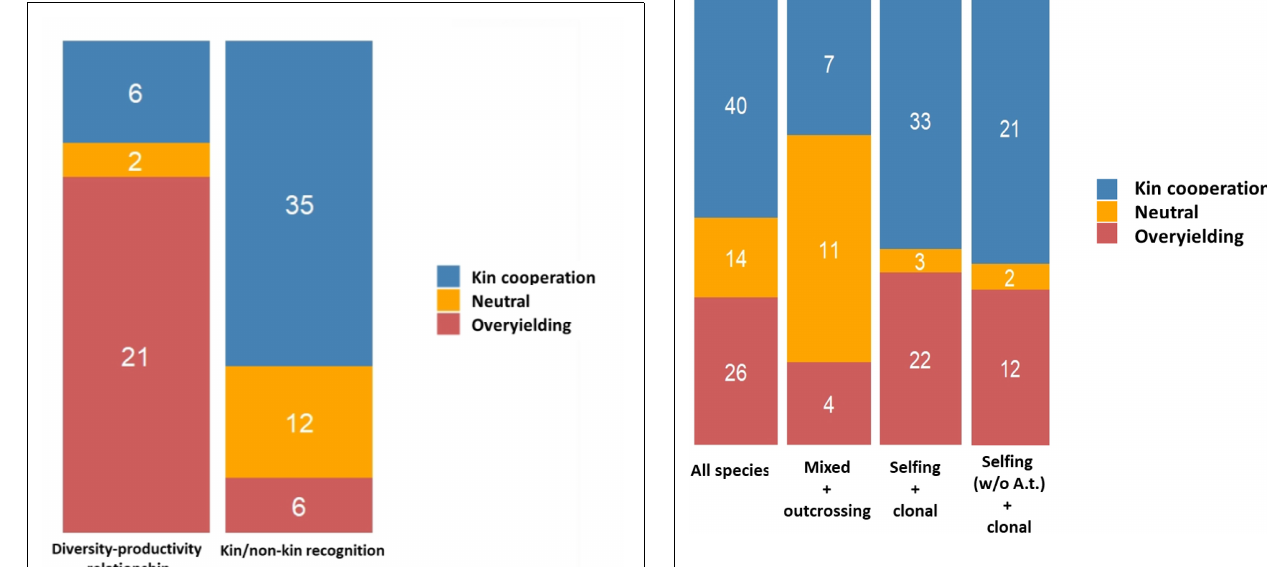
FIGURE 5 | Stacked barplots illustrating the different outcomes of GxG according to the breeding system of species studied. MIXED + OUTCROSSING: species with an outcrossing breeding system or with a mixed breeding system. SELFING + CLONAL: species with a selfing breeding system or a vegetative reproduction. SELFING W/O A.T. + CLONAL: species with a selfing breeding system (without considering Arabidopsis thaliana ) or a vegetative